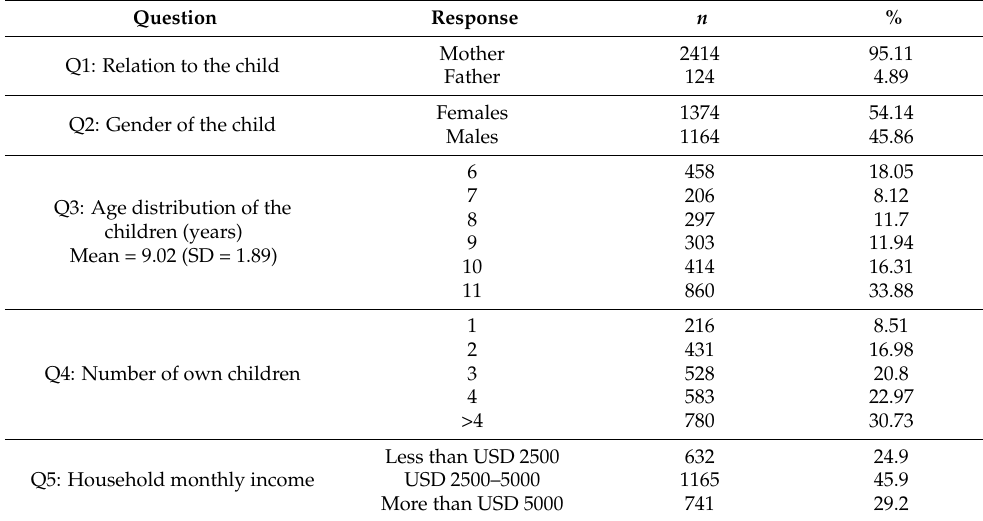
Table 1. Demographic information and characteristics of participants in the study ( n = 2538).